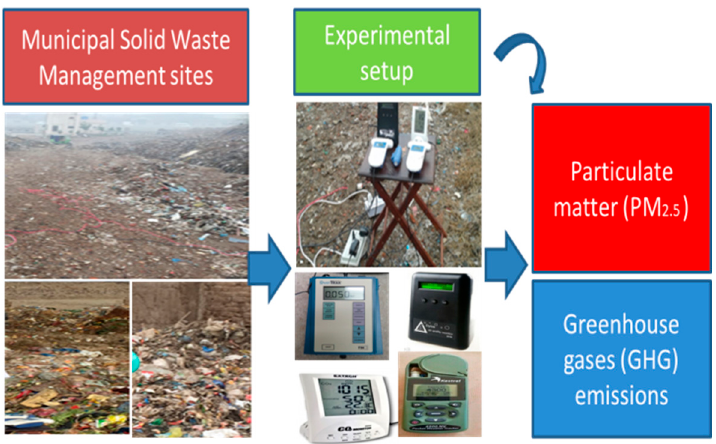
Figure 2. The conceptual diagram of experimental setup.